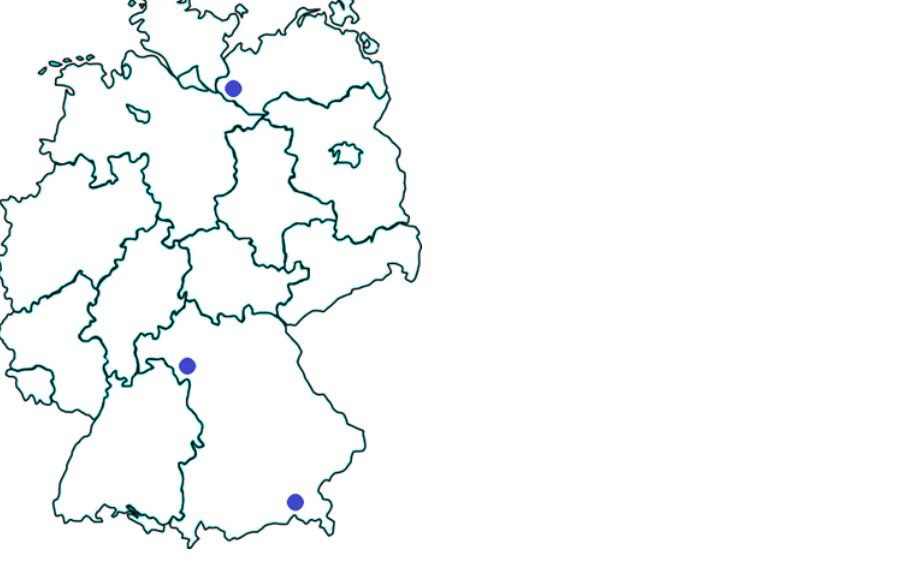
Figure 1. Location of the production sites under investigation: north (farms N1 – N5), central (farms C1 – C4) and south (farms S1 – S12); adapted from http://www.clker.com/clipart-germany-4.html# (accessed on 2 July 2021).